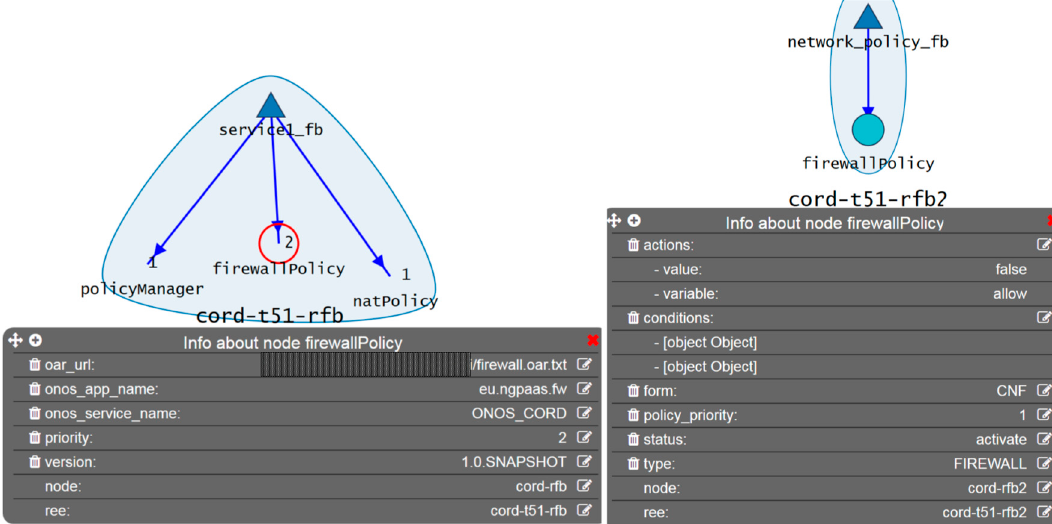
Figure 15. RFBisation of the policy framework. ( Left ) Deploys the ONOS applications comprising the policy framework ( Right ) Deploys an instance of a firewall policy.